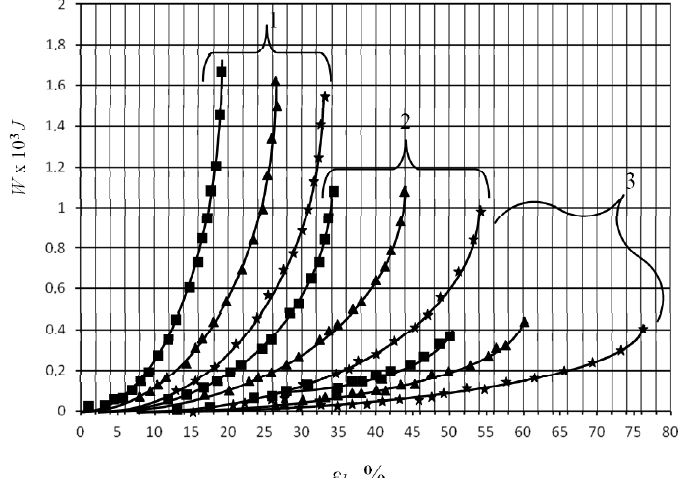
Figure 2: Dependence of the mechanical fracture energy on ruptural deformation of a PCM at temperatures: 1 – 223 K ; 2 – 273 K; 3 – 323